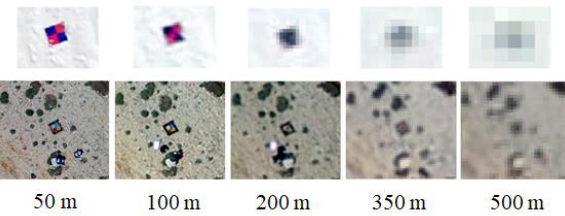
Figure A2: a) Temporal GCPs visibility and contrast on snow cover; b) permanent GCPs visibility and contrast on bare land.